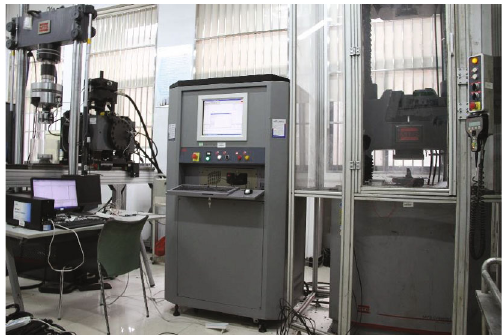
Figure 4: Experimental system for determining rock mechanical